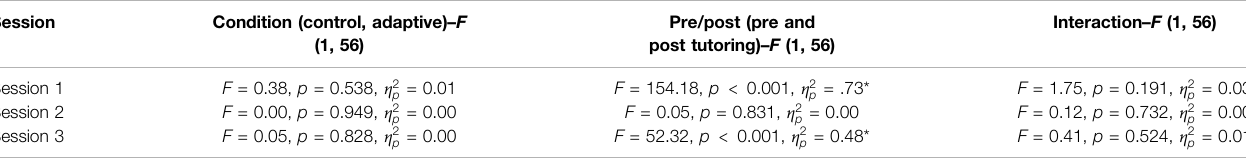
Interaction – F (1,